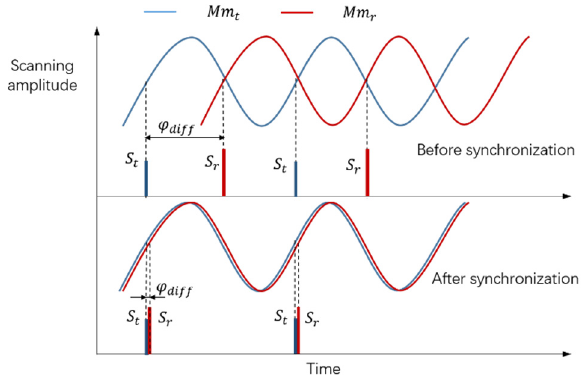
Figure 3. Procedure of the phase synchronization.